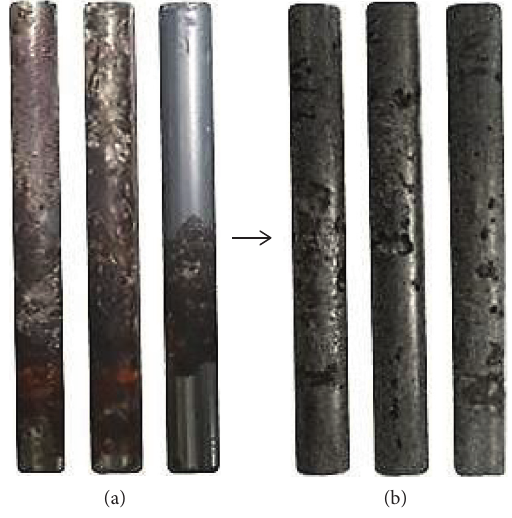
Figure 9: Visual aspect of bars after ECE treatment and immersion in hydrochloric acid (HCl, sp gr 1.19) at 25 ° C for 2 hours to clean the rust. Bars were brushed in addition for better results. The following cases depicted are in order from specimens treated with water, lithium borate, and calcium hydroxide, respectively, (a) right after treatment and (b) after rust were being released. Bound chlorides removed at farther depths from the steel bar may be the physically adsorbed ones that are usually adsorbed on the surface on the C-S-H gel or trapped between precipitated Ca(OH) molecules. 2